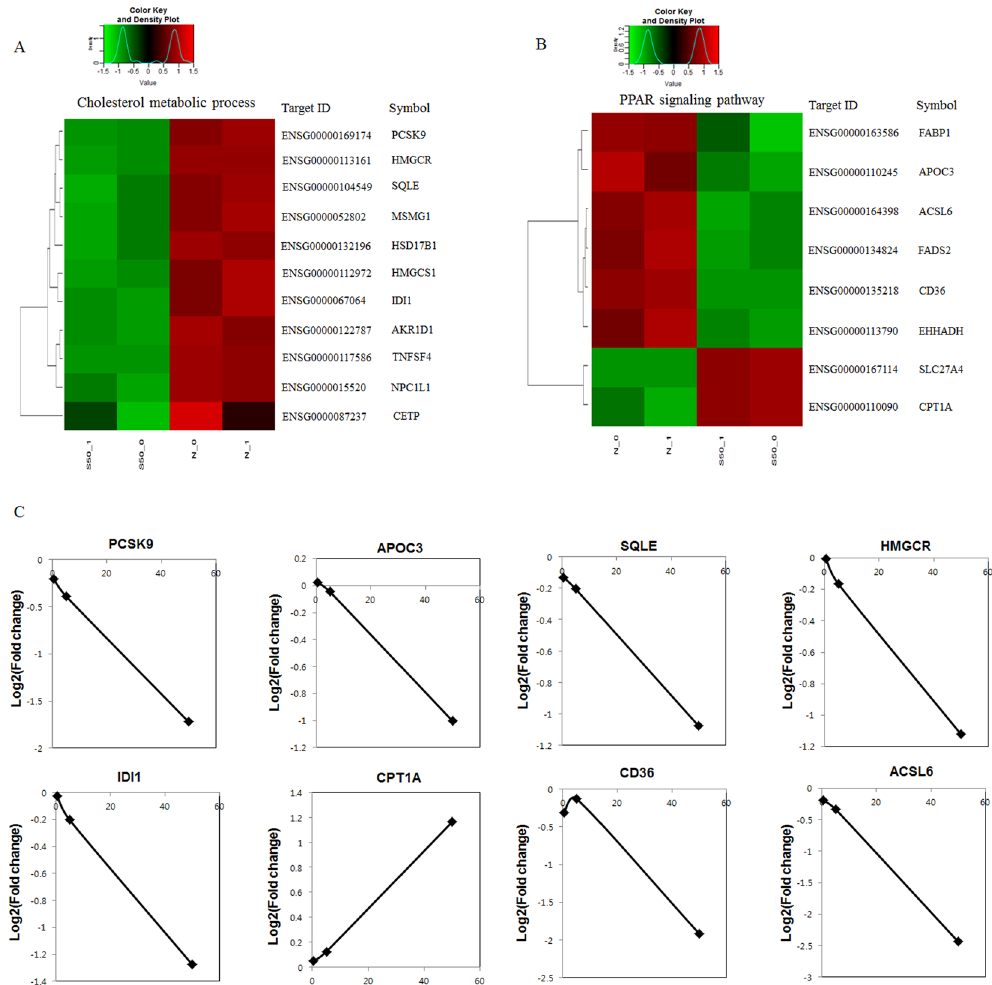
Figure 2. Metabolic genes regulated in HepG2 cells by sauchinone. ( A ) Sauchinone profiles for Cholesterol metabolic process: eleven genes for which the mRNA sequencing was > 2.0 and the flag was the p value (representing a higher expression). ( B ) Sauchinone profiles for PPAR signaling pathway: eight genes for which the mRNA sequencing was > 2.0 and the flag was the p value (representing a higher expression). ( C ) Validation of the metabolic gene profiles for the example genes by mRNA sequencing in HepG2 cells treated with sauchinone in a dose-dependent manner. Data represent the mean ± SD of triplicate